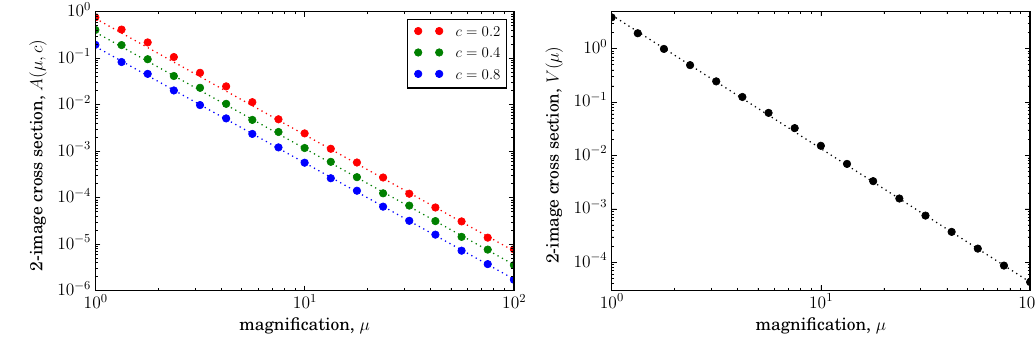
Figure 4. ( left ) The colored points show the area cross section A ( µ , c ) in the two-image region, computed numerically for different c -slices. The dotted lines show the scaling A ( µ , c ) ∝ µ − 2.5 . ( right ) The points show the volume cross section V ( µ ) in the two-image region, computed by integrating c over the range [ 0.1,1.0 ] . The dotted line shows the scaling V ( µ ) ∝ µ − 2.5